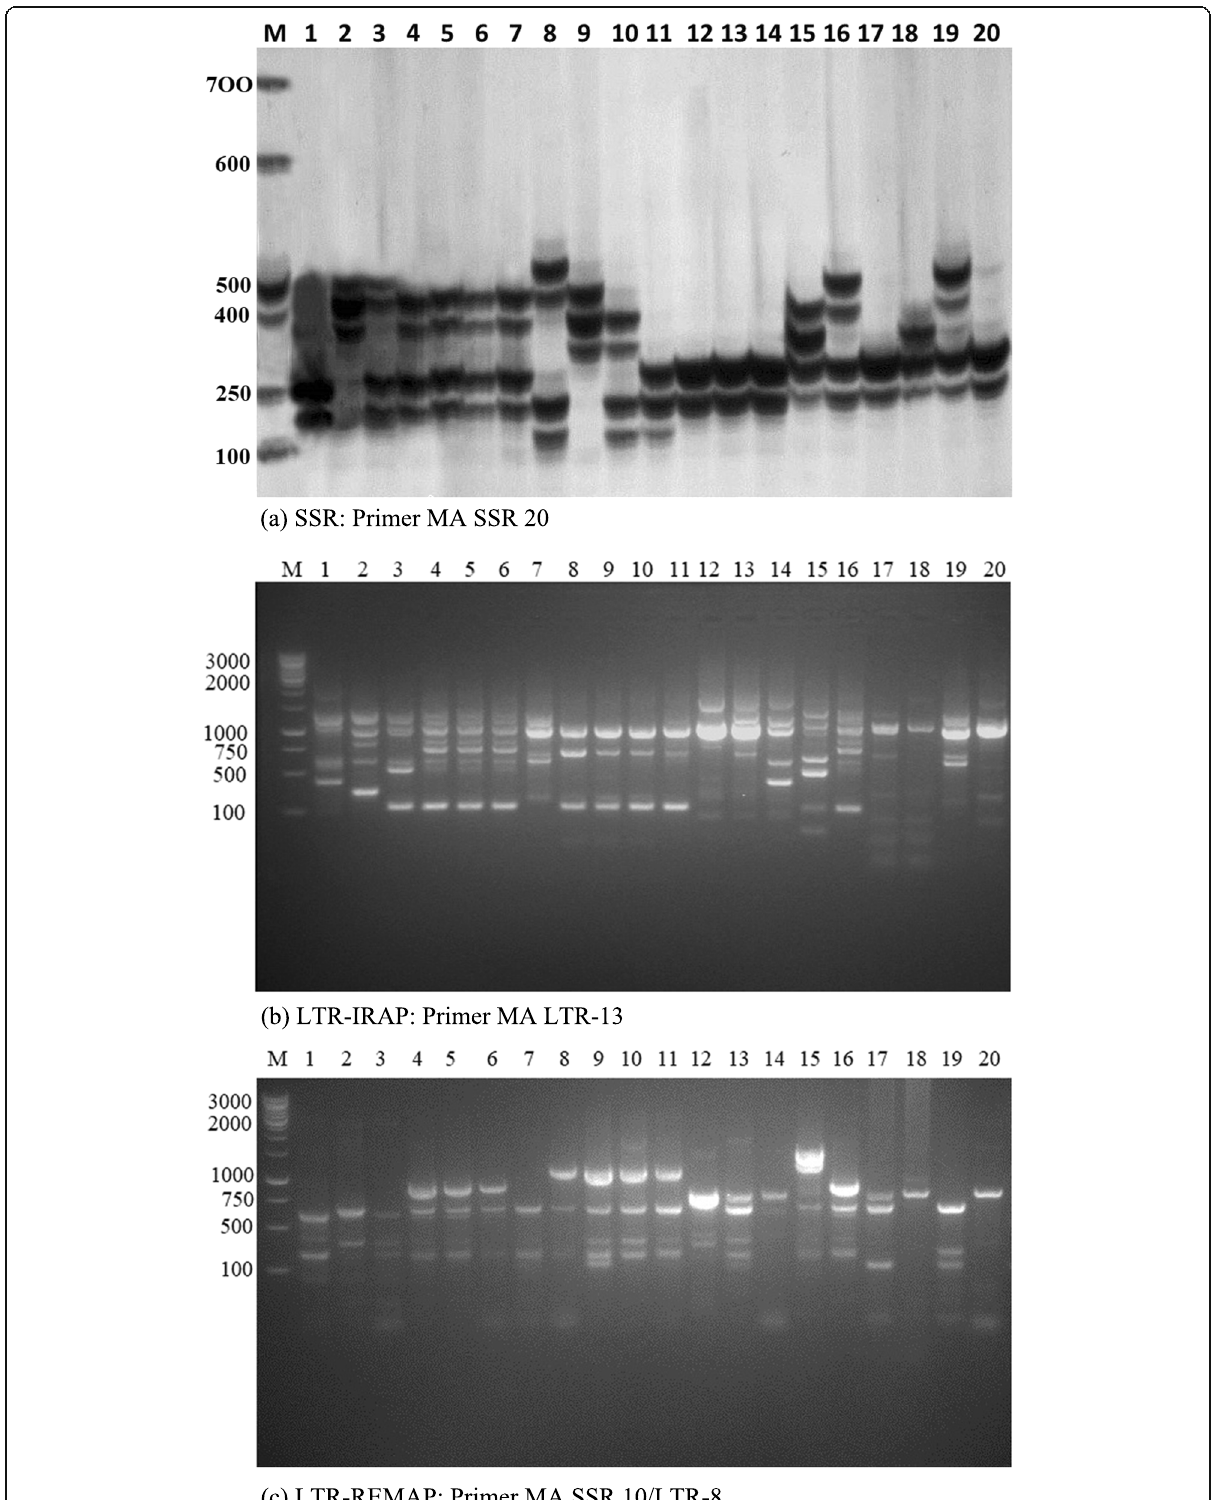
Fig. 1 a SSR, b LTR-IRAP, and c LTR-REMAP profiles of 20 citrus